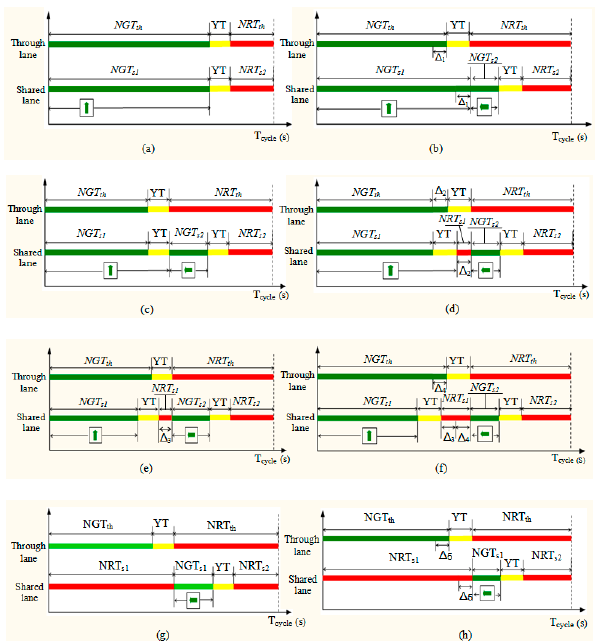
ff erent conditions: ( a ) Flag = 1 and T